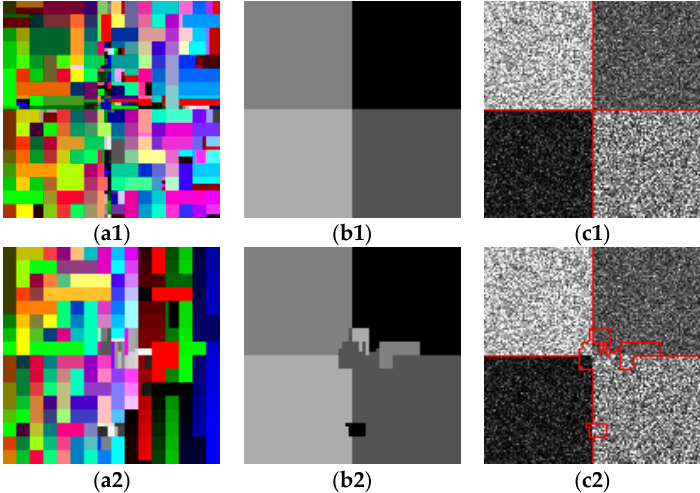
Figure 4. Energy histograms of a simulated SAR image: ( a ) Curvelet, ( b ) wavelet.